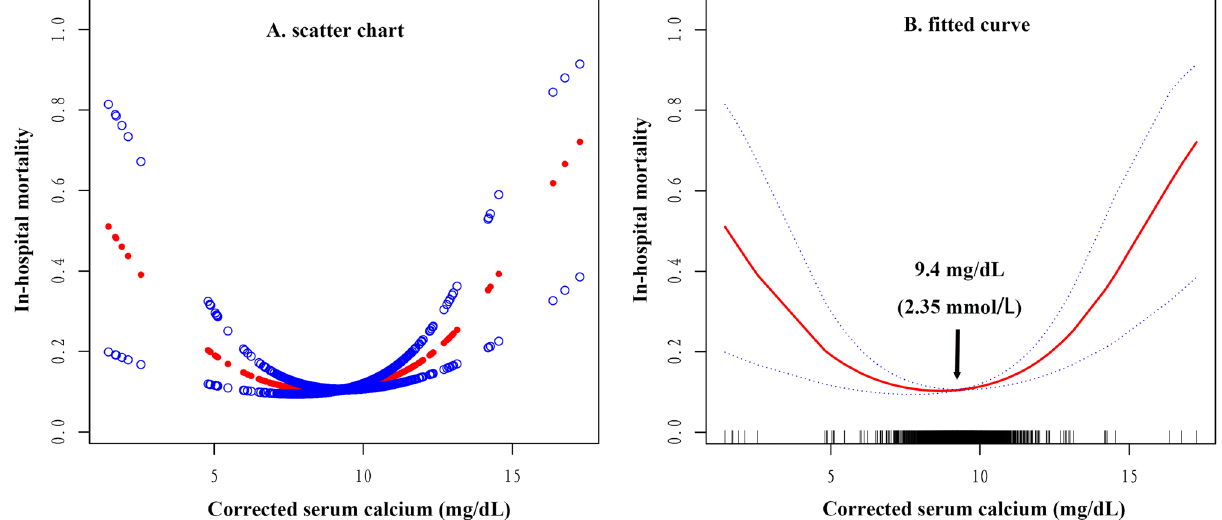
Figure 2. The illustrated curved line relation between serum calcium and in-hospital mortality. ( A ) The density of the scatter points represents the number of patients. ( B ) Fitted curve was drawn to more clearly present the association between corrected serum calcium and in-hospital mortality in patients with AMI. According to the threshold analysis, the curve’s inflection point is 9.4 mg/dL (2.35 mmol/L). The area between two blue lines (dotted lines) is a 95%